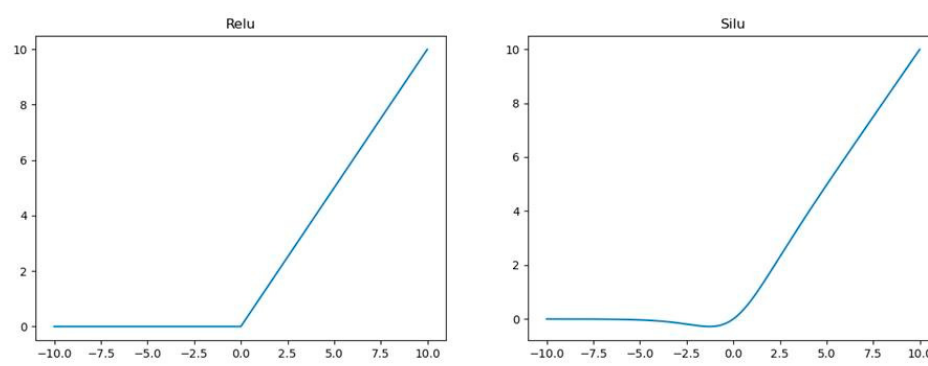
Figure 3. Relu and Silu activation function graphs.